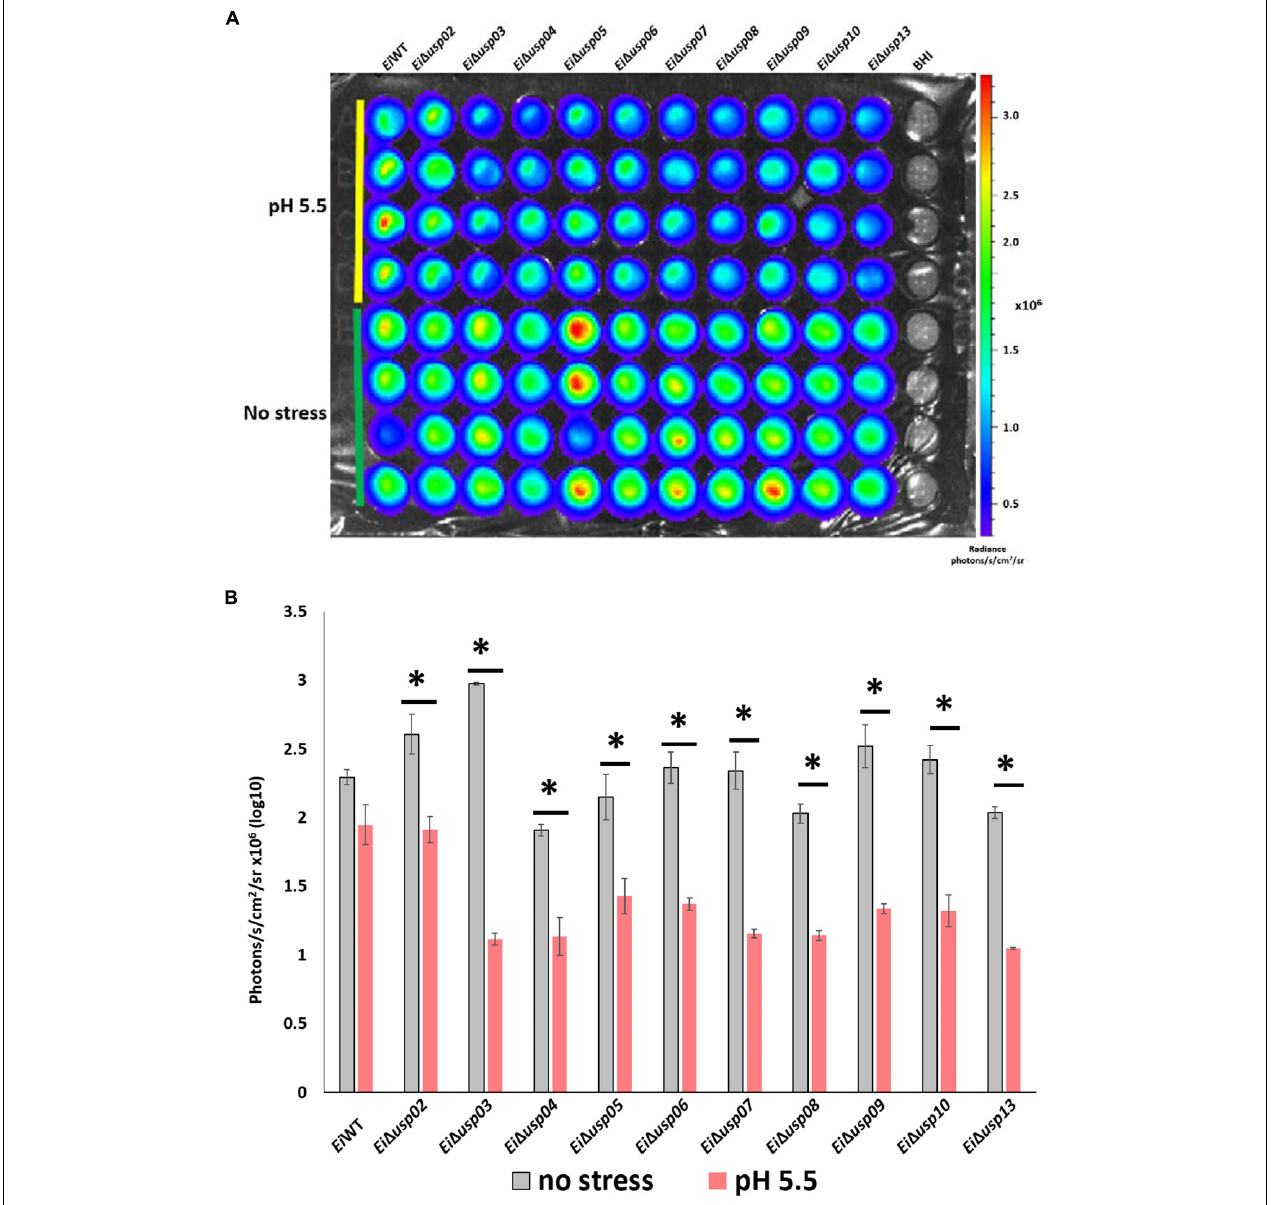
FIGURE 4 | The survival assay of E. ictaluri WT and USP mutants in pH 5.5. (A) Each strain had four replicates (column A–D). Strains start with E. ictaluri WT , Ei (cid:49) usp02-13 and BHI control. (B) The bars show the difference between bioluminescence of USP mutants and WT. ∗ indicates a significant difference between stress and non-stress at P <